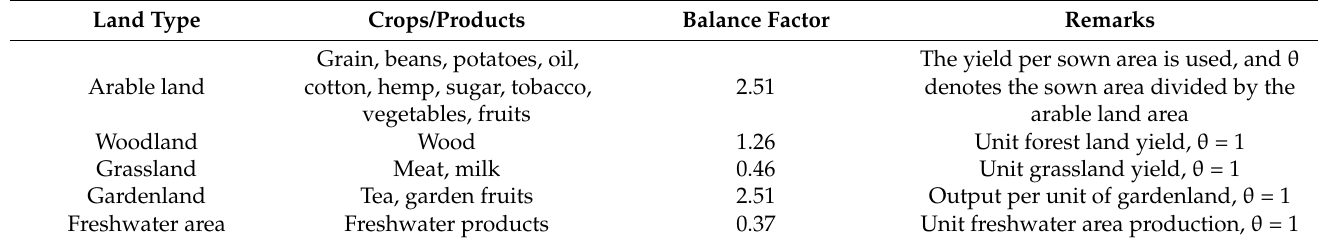
Table 1. Relationships between land use types and crops/agricultural